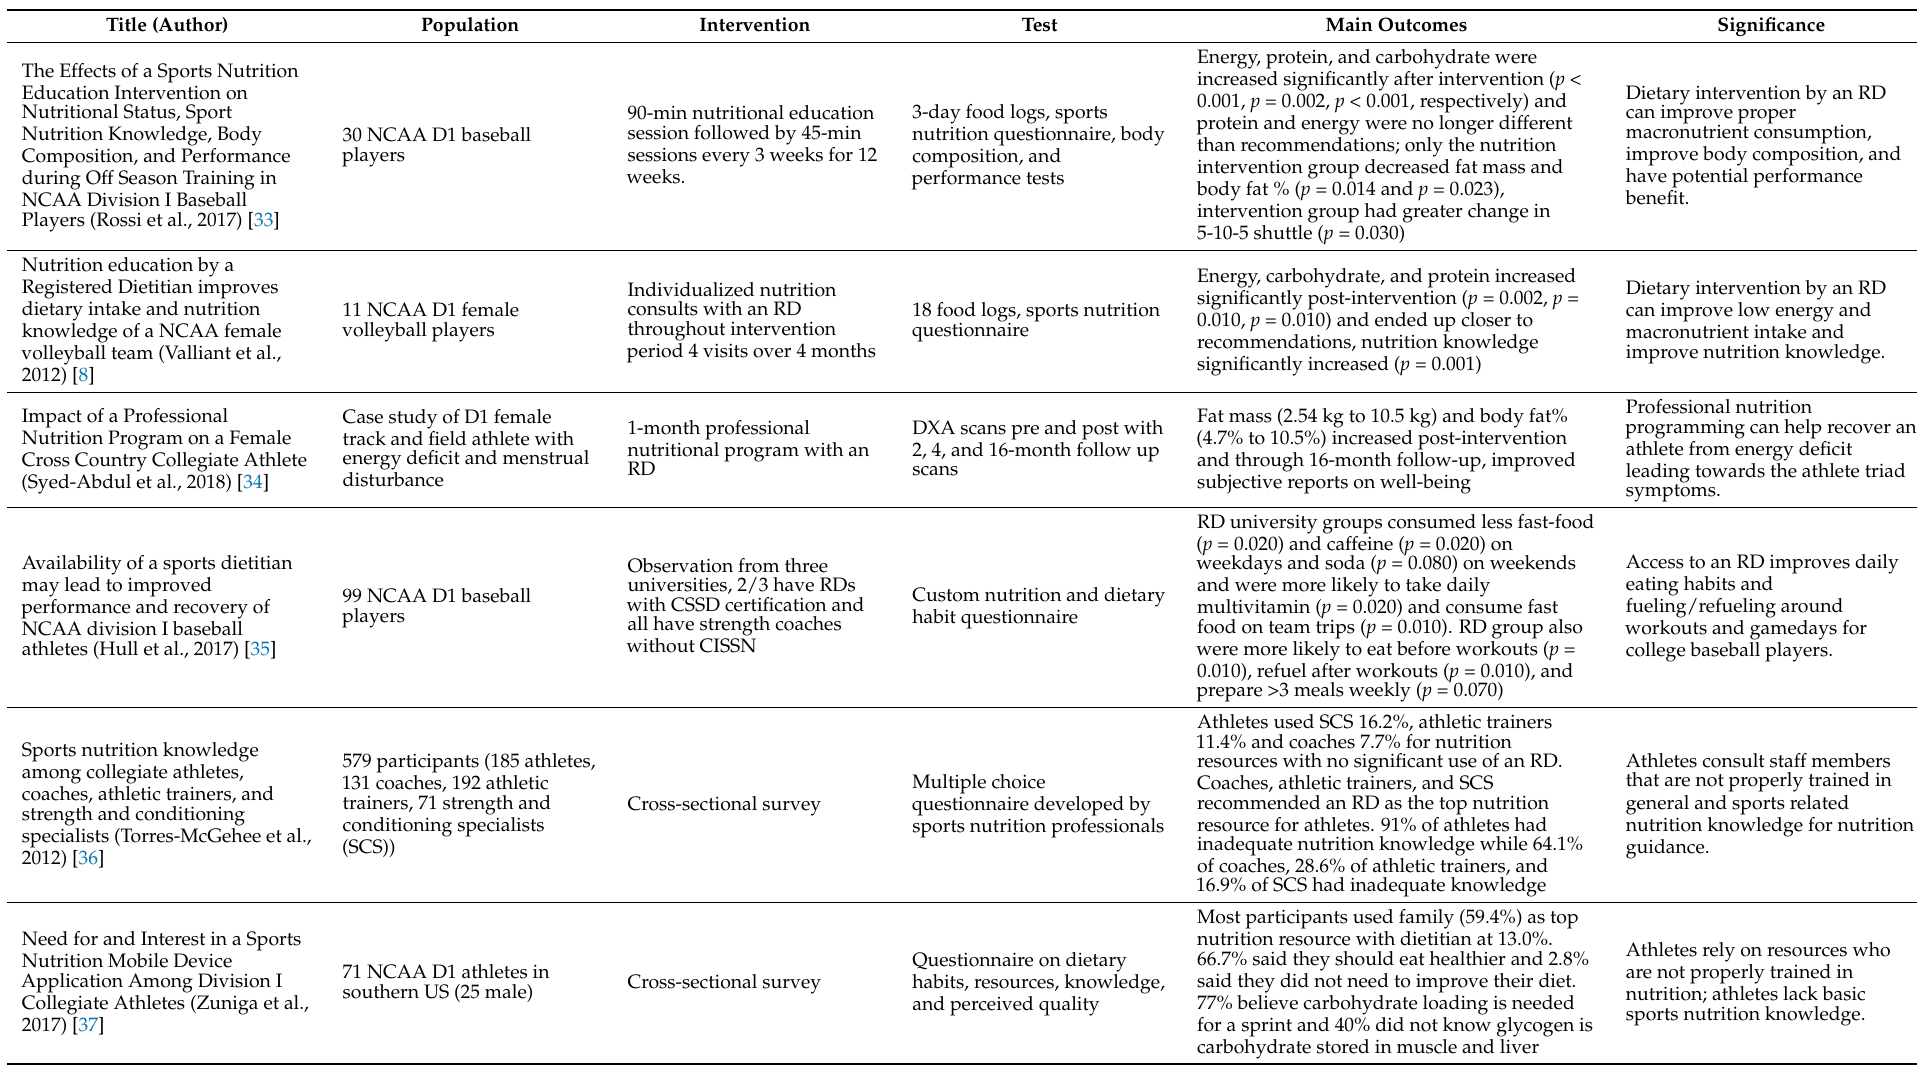
Table 2. Summary table of articles used demonstrating efficacy of sports